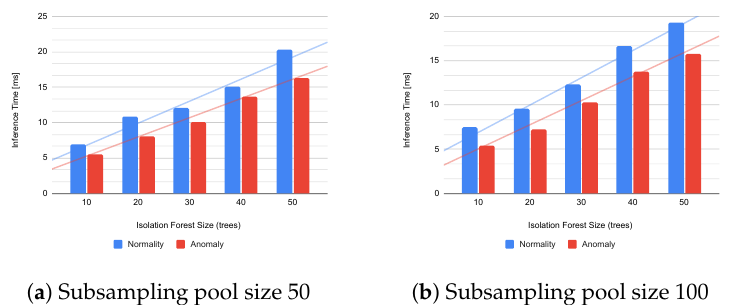
Figure 5. Inference delay for IF trained (training size 100) with a subsampling pool of 50 ( a ) and 100 instances ( b ). Straight lines are the trend line showing the linear dependence between the ensemble size and inference